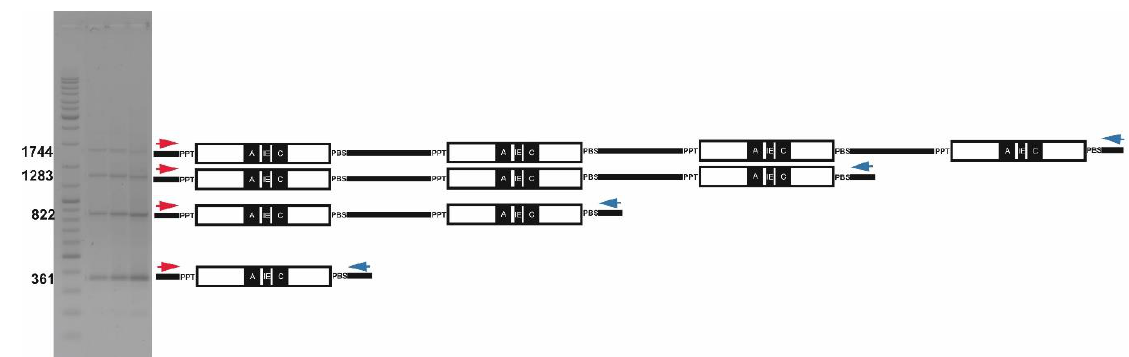
Figure 2. Tandem structure and long-distance PCR (3801-3802), applied to Cassandra ( Avena sativa ), multimeric tandem repeats are generated (gel image on the left). Forward primers (red arrows) and reverse primers (blue arrows) respectively.